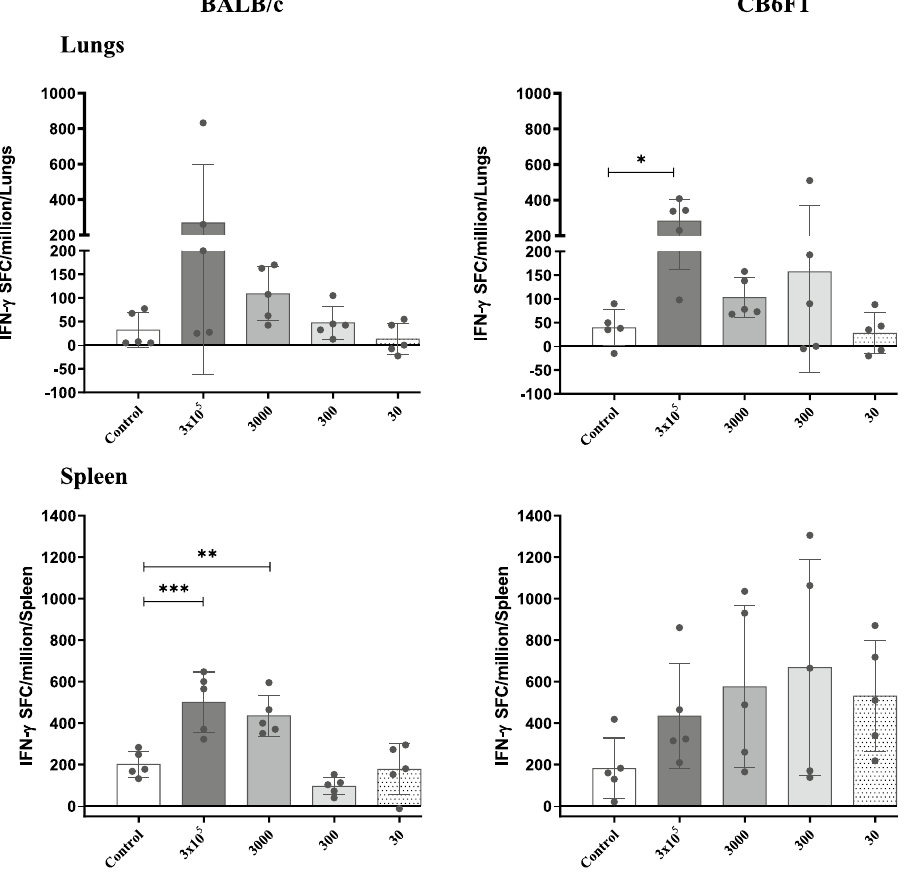
Figure 4. IFNγ secreting cells in the lungs and spleen of BALB/c and CB6F1 mice. The lung cells and splenocytes were isolated from 6 weeks post BCG vaccinated BALB/c and CB6F1 mice (five mice/group) and the frequency of IFNγ secreting cells evaluated by ex vivo ELISPOT. Data is the representative of two independent experiments for BALB/c and one experiment for CB6F1 mice. Approximately 2 × 10 5 cells were cultured with or without M7 protein cocktail and developed by ELISPOT assay. For the data interpretation, the frequency of M7-stimulated IFNγ secreting cells were subtracted from the frequency of IFNγ secreting cells with no antigen stimulation. Bars representing mean (±S.E.) Spot Forming Cells (SFC) per million. Statistical analysis: One-way ANOVA, Dunnett’s multiple comparison test was performed. *ρ < 0.05, **ρ < 0.005, ***ρ <